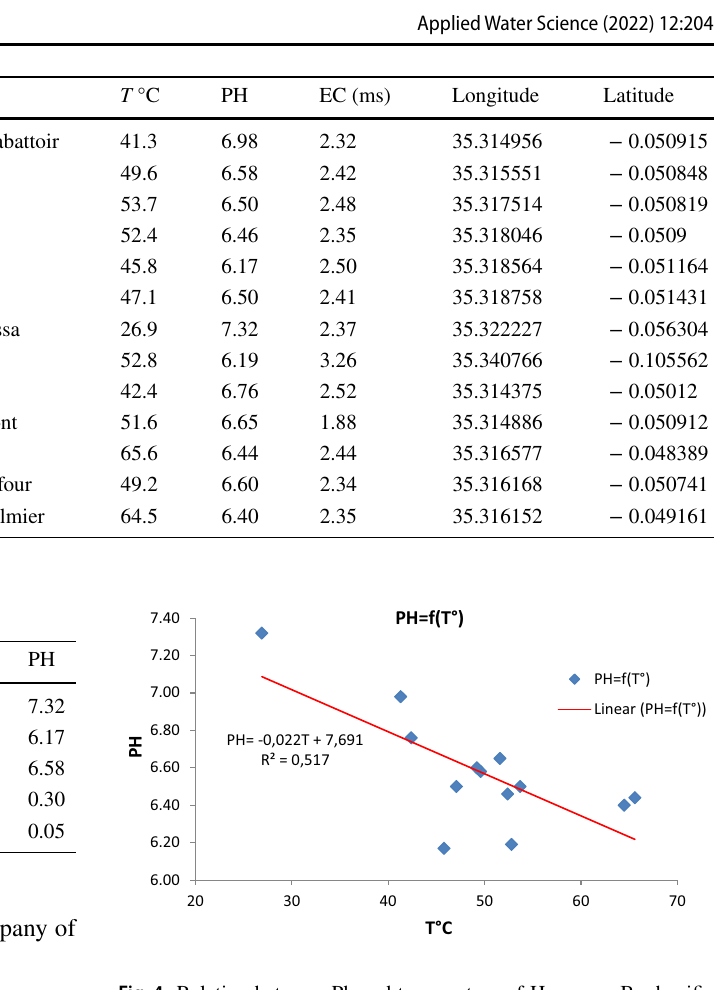
Fig. 4 Relation between Ph and temperature of Hammam Bouhanifia Spring